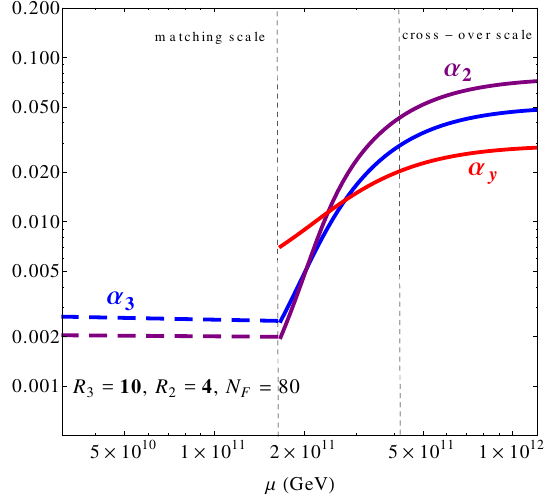
Figure 9 . Low scale matching from the partially interacting (cid:12)xed point FP 3 onto the SM for the benchmark scenario C with ( R 3 ; R 2 ; N F ) = ( 10 ; 4 ; 80) and M = 2 TeV. BSM (SM) running is shown by full (dashed) lines. Around the cross-over scale the BSM running of (cid:11) 3 and (cid:11) y slows down from power-law to logarithmic. Notice that the approach towards asymptotic freedom of the weak coupling is enhanced by BSM fermions.